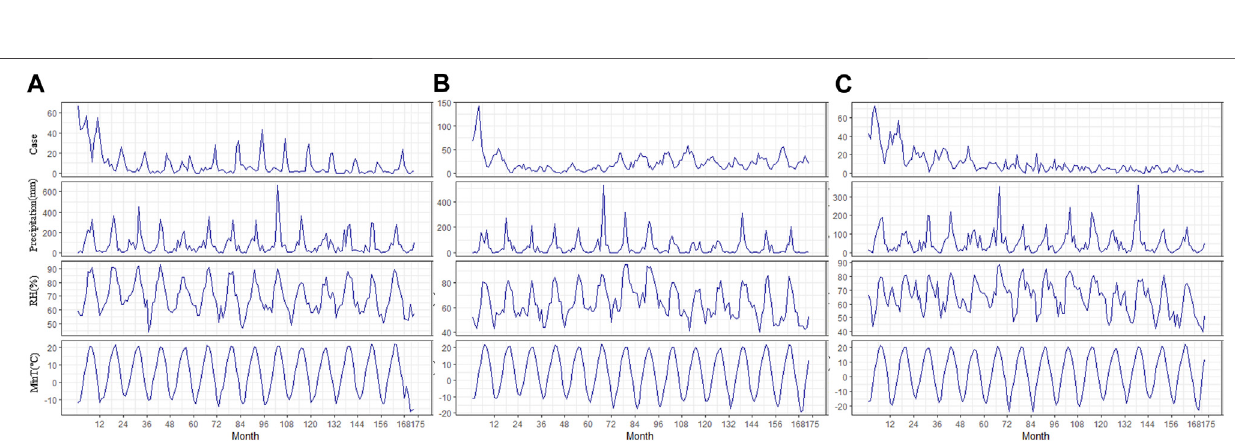
Frontiers in Environmental Science |